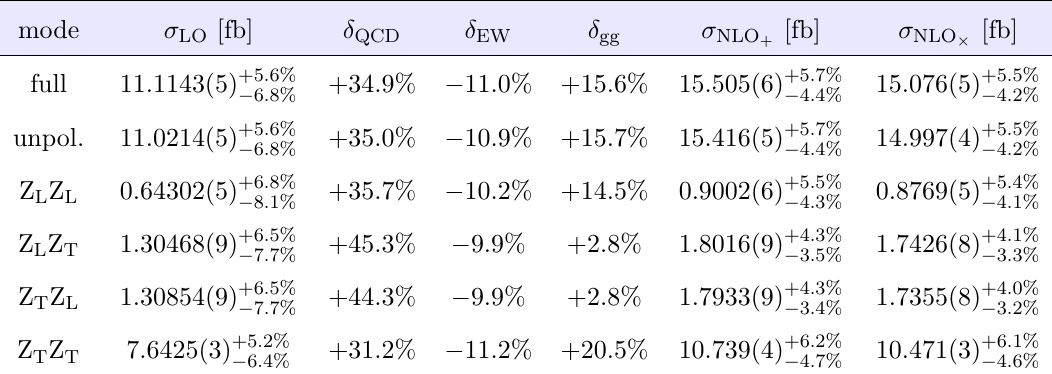
Table 3 . Integrated cross-sections in the fiducial setup (see section 2.5) for unpolarized and doubly- polarized ZZ production at the LHC at LO and NLO accuracy. Polarizations are defined in the CM frame. Corrections are shown as percentages relative to LO cross-sections. The NLO cross-sections include NLO EW and QCD corrections and the loop-induced gg contribution, combined with the additive (+) or multiplicative ( × ) prescription. Theory uncertainties from 7-point scale variations are shown as percentages for the LO and NLO results. Parentheses contain integration